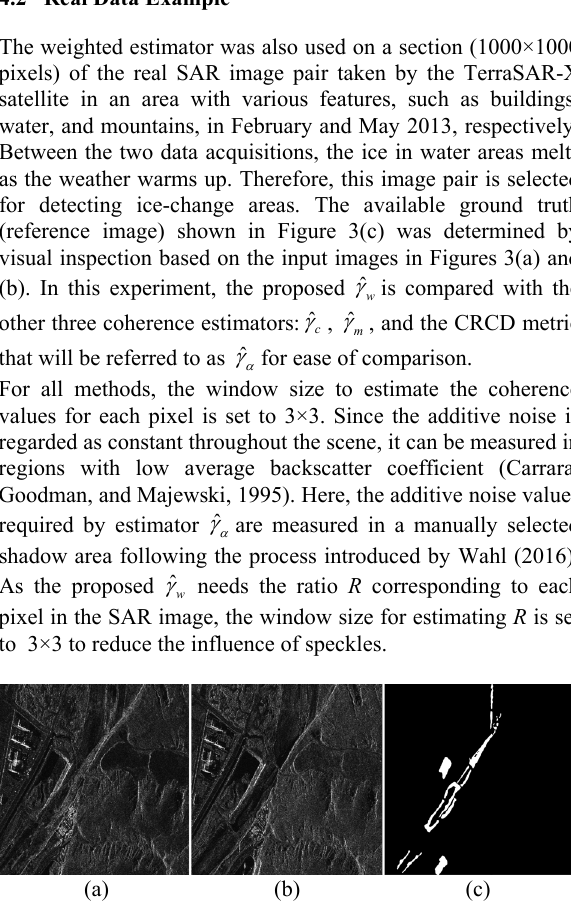
Figure 3 . Multitemporal SAR image pair used in the experiment. (a) Image acquired in February 2013 covering frozen water areas. (b) Image acquired in May 2013 covering unfrozen water areas. (c) Ground truth.